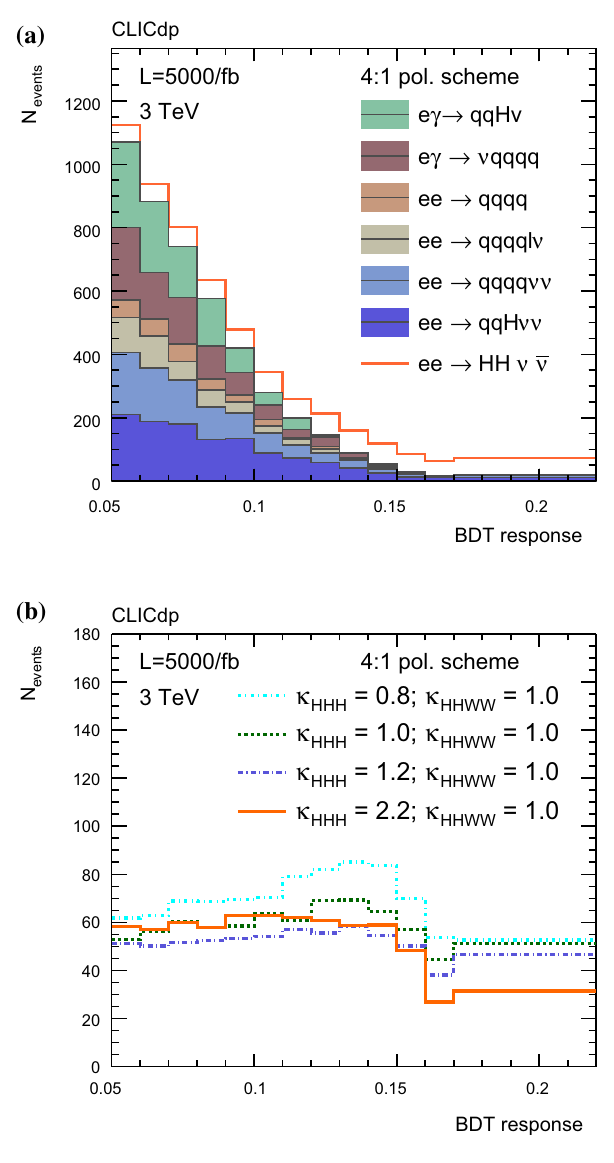
Fig. 5 BDT response distribution of a all SM contributions stacked and b aselectionofsignalsampleswithmodified g HHH inthelooseBDT selection at 3TeV CLIC. The Higgs-gauge boson coupling g HHWW is kept at its SM value